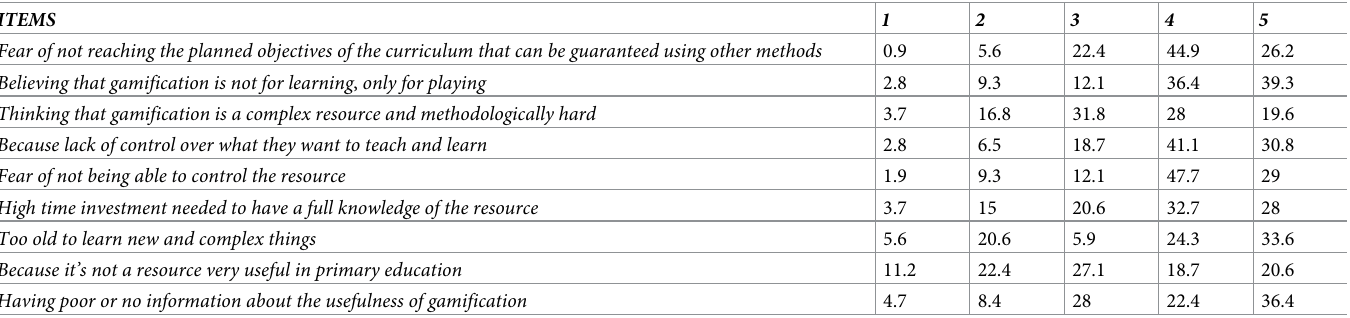
Table 4. Descriptive results on the difficulties of using